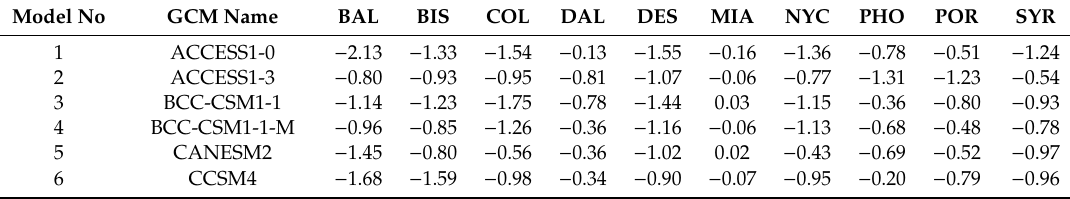
Table A7. NSE coe ffi cient of total between observed and simulated data